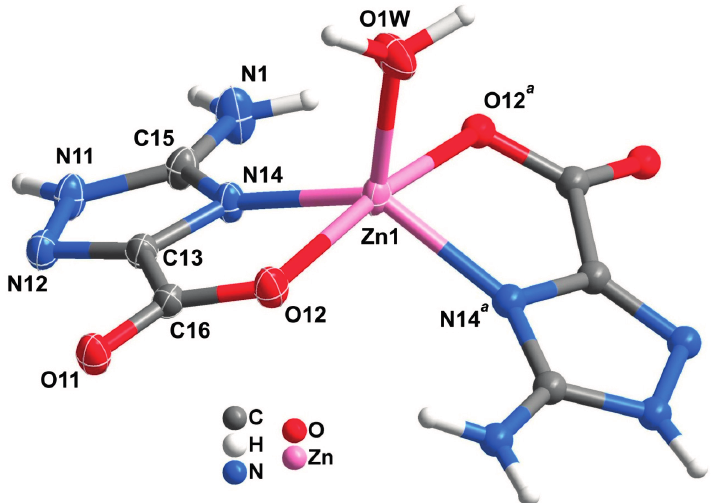
Figure 1. Schematic representation of the mononuclear complex [Zn(Hatrc) 2 (H 2 O)] present in compound 1 , showing the labelling scheme for all non-H atoms composing the asu and those forming the metal coordination sphere. Non-H atoms of the asu are drawn as thermal ellipsoids at the 30% probability level and the remaining atoms as spheres with arbitrary radius. For selected bond lengths and angles see Table 1. Symmetry transformation: a = 1 − x , y , 1.5 −